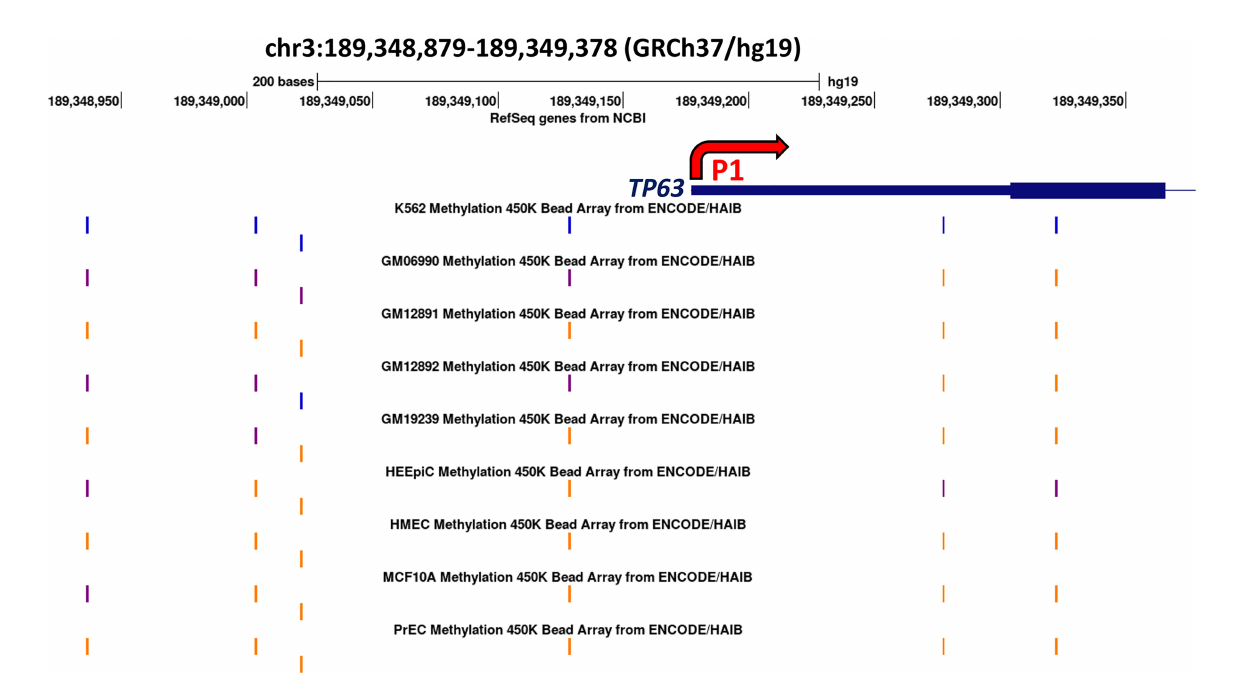
FIGURE 6 | Methylation array data surrounding the P1 promoter of the human TP63 gene for nine cell lines . The blue line indicates the transcription start site of TAp63 mRNA and the thicker blue line indicates the coding sequence of TAP63 exon 1. The thin line indicates intron 1. Methylation levels of the six CpG sites present on the 450K bead array are shown; orange indicates high methylation (methylation score >= 600) blue indicates low methylation (<=200) and purple indicates intermediate methylation at each site on the array. Data are derived from UCSC (http://genome-euro.ucsc.edu/cgi-bin/hgGateway?redirect=manual) using DNA methylation data from ENCODE (26) overlaid onto the hg19 genome sequence. (K562, CML blast crisis; GM06990, GM12891, GM12892, and GM19239 are EBV-transformed B-lymphoblasts; HEEpiC, esophageal epithelial cells; HMEC, mammary epithelial cells; MCF10A, mammary epithelial cells (containing ER-Src); PrEC, prostate epithelial